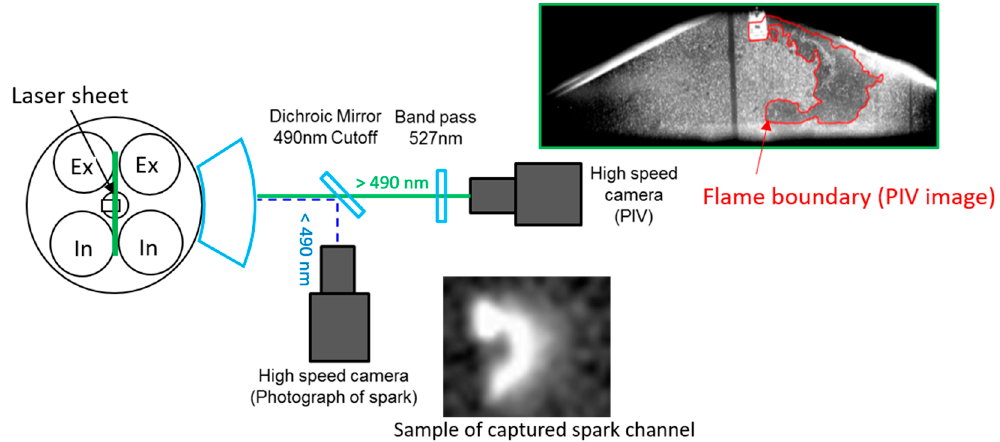
Figure 2. Simultaneous setup for PIV / flame imaging and high-speed spark imaging, together with their sample raw images.